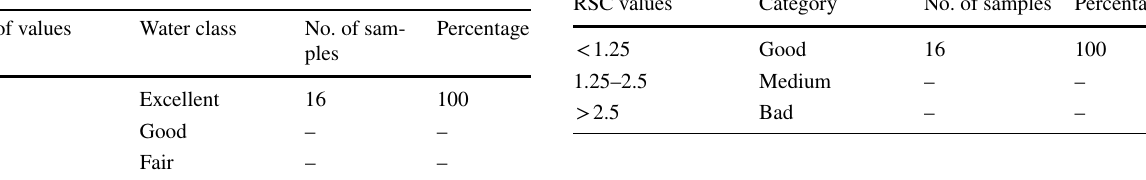
Table 4 Suitability of groundwater for irrigation purpose based on SAR (Richards 1954) in the Bekal watershed areas Range of values